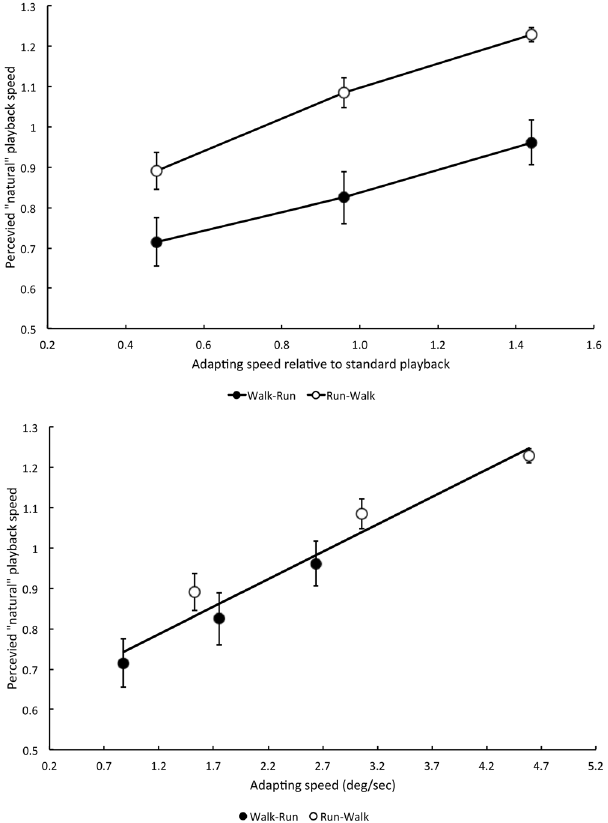
Figure 2. Results of Experiment 3 involving cross-adaptation between running and walking. Filled circles Data using walking adapt and running test videos (Walk-Run). Unfilled Circles Data using running adapt and walking test videos (Run-Walk). The upper graph plots results in terms of the norm-based speed of the adapting pattern (i.e. relative to standard-speed playback). The lower graph plots results in terms of the mean retinal speed of the adapting pattern. Figure convention as in Fig. 1. Each data point represents the mean P50 of five participants ( + / − 1